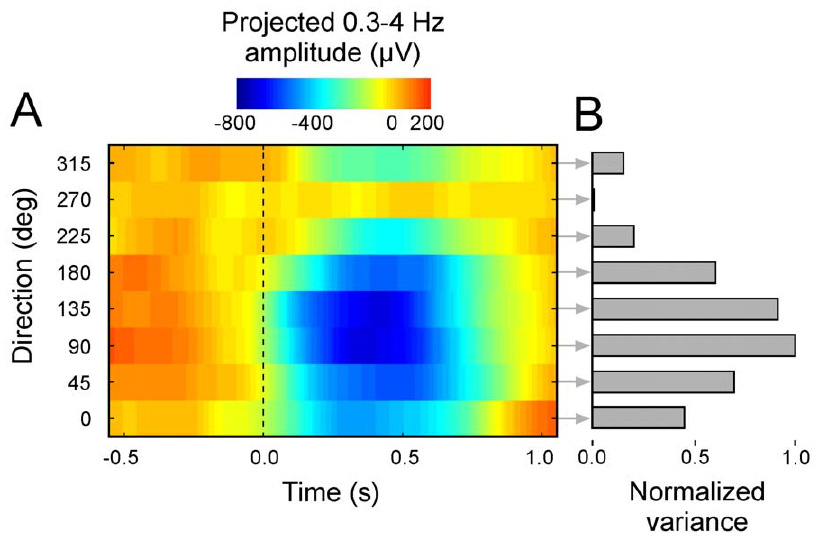
Figure 3. Projected data. (A) Projections of 0.3–4 Hz LFP data from all channels using a spatial filter tuned to maximize the variance for the 90 deg direction and minimize the variance for the 270 deg direction. The projections were ordered along the ordinate according to target direction. The vertical dashed line indicates movement onset. (B) Variance of the spatial projection for each target direction in Fig. 3A. The variance was normalized to the maximum value. Note that the variance was maximum for 90 deg and minimum for 270 deg by design of the spatial filter, and that it varied progressively across direction. This characteristic indicates that LFP correlation structure across channels changed progressively with direction.